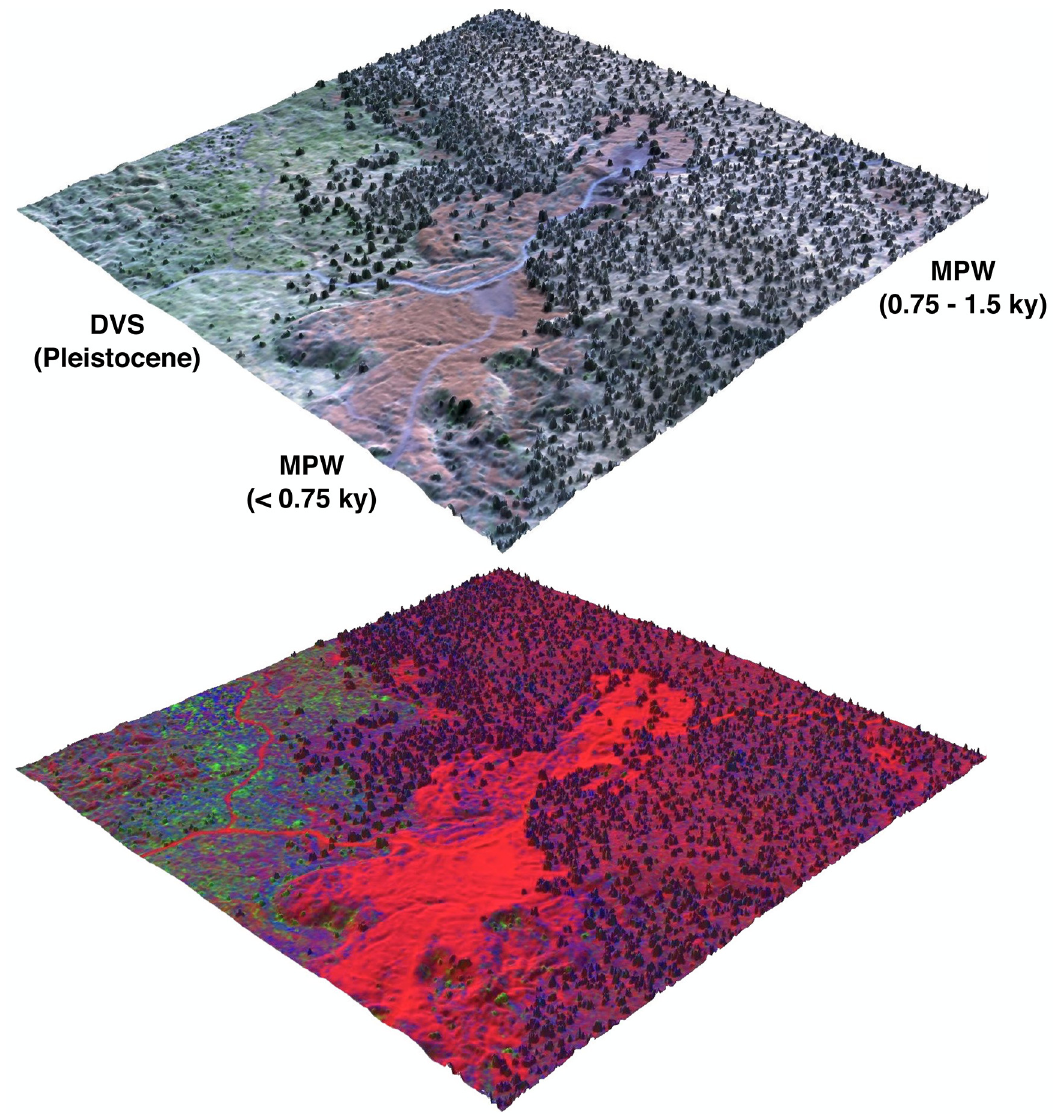
Fig 1. Airborne imaging spectroscopy and LiDAR can be used to quantify the composition and fractional cover of vegetation. The top image is a true color composite overlaid on the digital terrain model (DTM). The bottom image is an RGB composite of the same area processed to quantify barren substrate (B, r ed), photosynthetic vegetation (PV; g reen) and non-photosynthetic vegetation (NPV; b lue). Changes in the lateral distribution of PV, NPV, B, and height are apparent across the substrate age gradient. For example, M . polymorpha woodland (MPW) on the 750 – 1200 year-old substrate is dominated by B and tall-statured NPV, indicated by reds and blues in the bottom panel. In contrast, D . viscosa shrubland (DVS) on a Pleistocene aged substrate is dominated by short-statured NPV and PV, indicated by blues and greens in the bottom panel. The areas shown are a 1 km 2 sample of the 23.1 km 2 study area mapped at 2.2 m